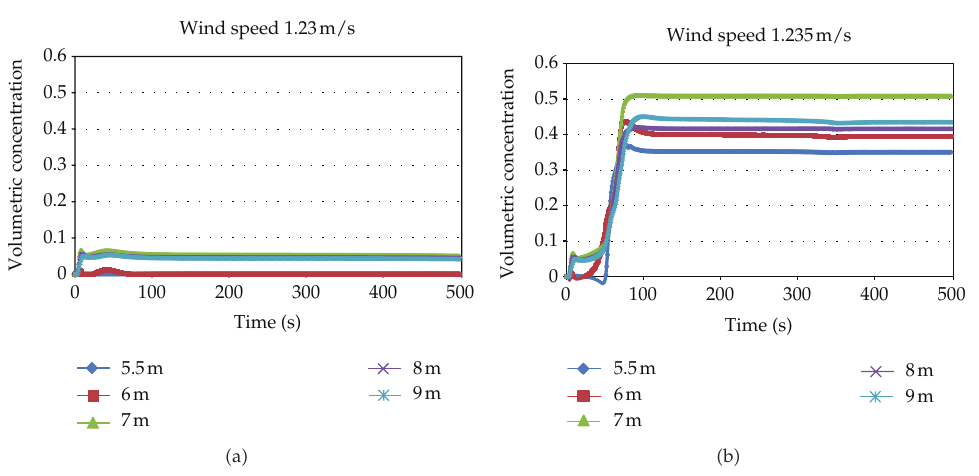
Figure 5: Model 1: plots of volumetric concentration versus time for wind speed 1.23 and 1.235ms − 1 .